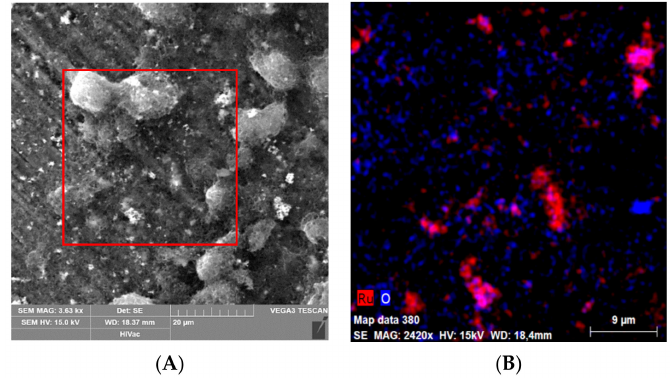
Figure 3. Scanning electron microscopy ( A ) and elemental mapping ( B ) of GCE / MWCNTs-RuO 2 surface. Both images were taken at the same site.